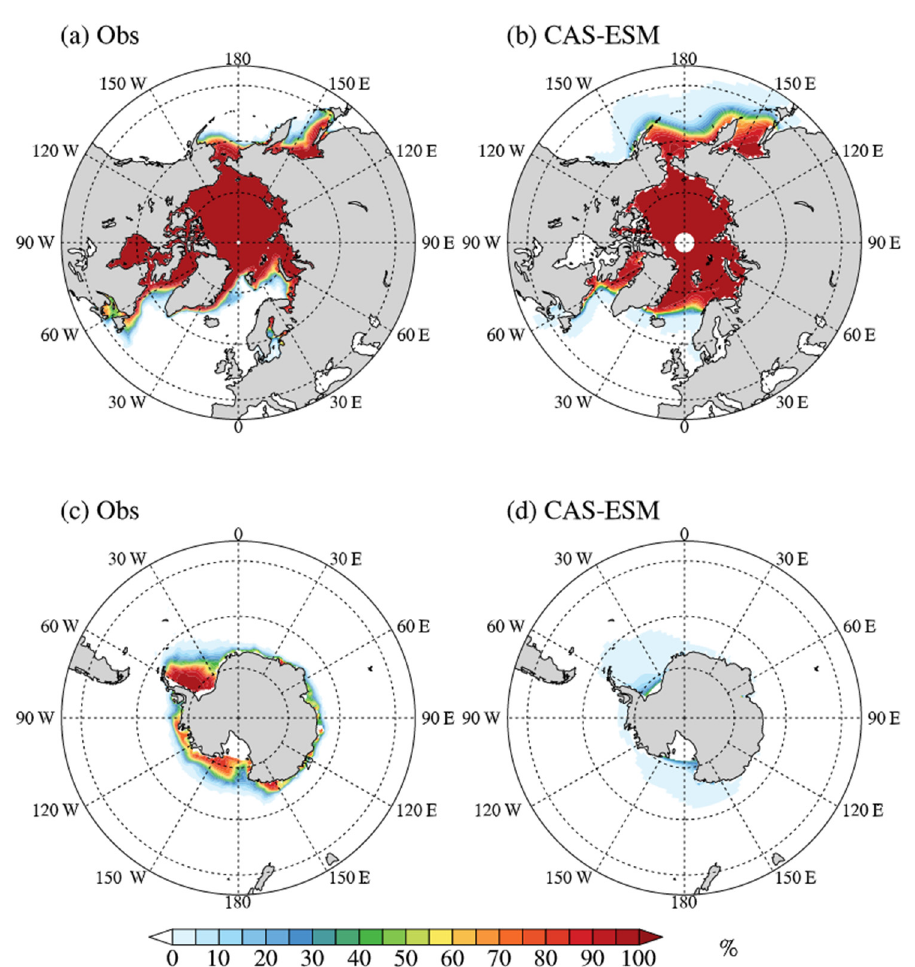
Figure 3. Spatial patterns of ( a , c ) SSMI observations from March 1980–2014 and ( b , d ) CAS-ESM 2.0 ensemble mean sea ice concentrations for March 1979–2014 in historical simulation, in Northern Hemisphere (upper panel) and Southern Hemisphere (lower panel).